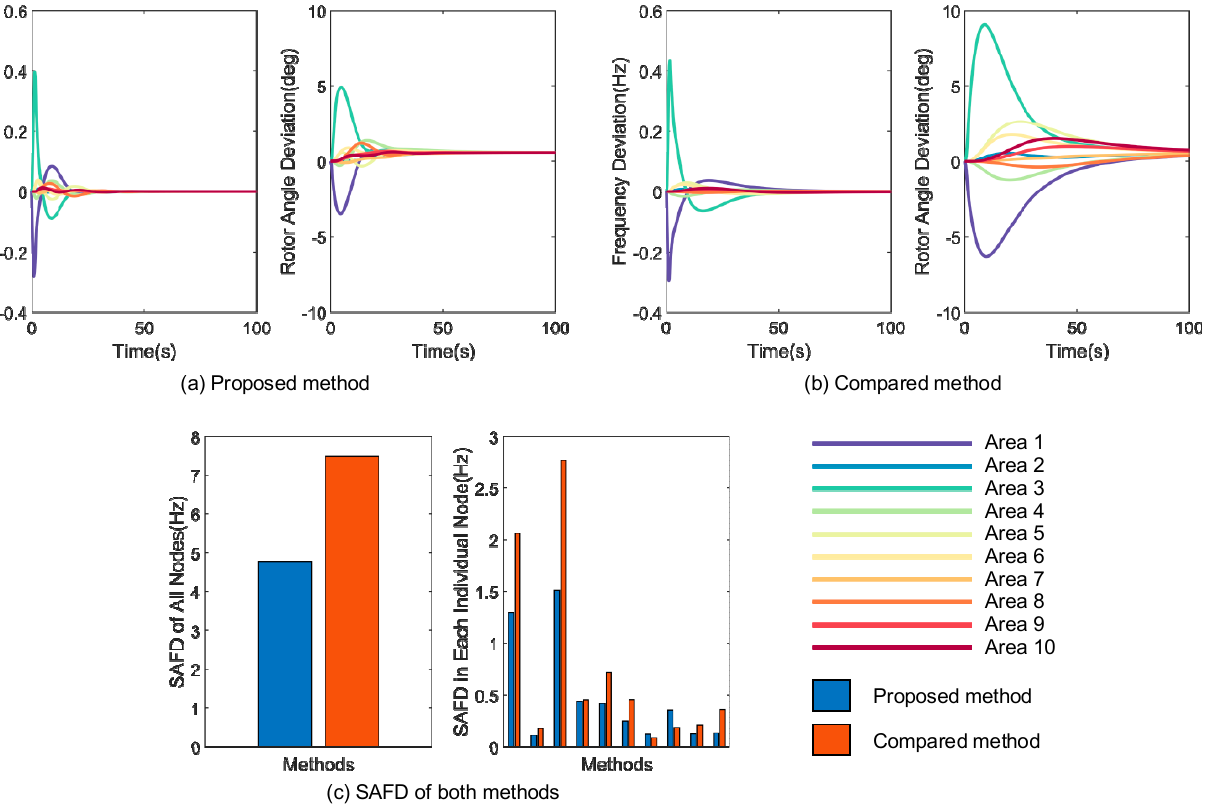
Figure 11. Frequency deviation, rotor angle deviation and sum of absolute frequency deviation (SAFD) of both methods in the frequency event E.